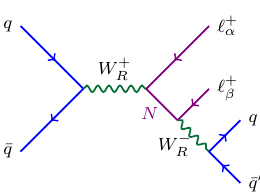
Figure 12. Feynman diagram for production of heavy W R boson at future hadron colliders (cf. the process in Equation